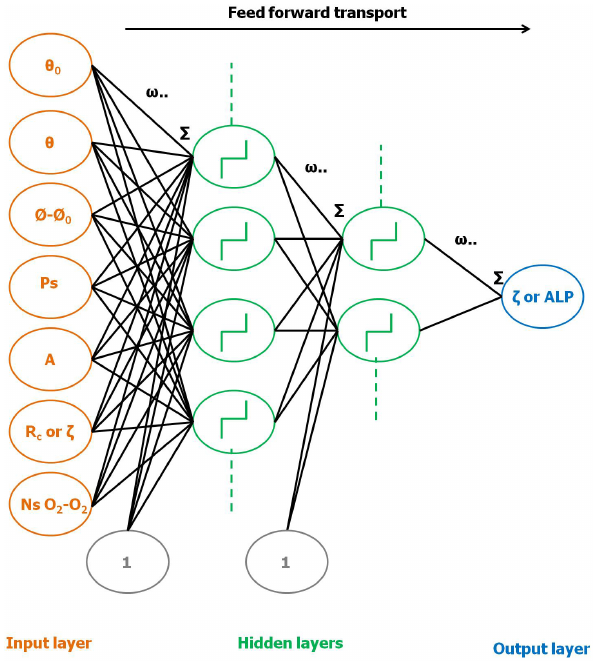
Figure 2. Diagram of multilayer perceptron (MLP) neural net- work (NN) architecture designed for aerosol layer pressure (ALP) and aerosol optical thickness τ retrieval algorithms from the OMI O 2 − O 2 spectral band at 477nm. The input parameters are based on the list given in Table 1. The different considered approaches for the MLP design and their applications are more detailed in Sect. 3. Each circle represents a specific processor (named neuron) includ- ing either an input–output variable (in the input–output layer) or the activation function (i.e. sigmoid function in the hidden layer). The synaptic weights ω ensure the connections of neurons between two consecutive layers. A weighted sum P is performed before the transport through the activation function. Note the presence of the bias neurons, prior to the activation functions in the hidden lay- ers. For simplicity, bias neurons are commonly visualized as val- ues added to each neuron in the input and hidden layers of a net- work, but in practice are treated in exactly the same manner as other weights: all biases are simply weights associated with vectors that lead from a single node whose location is outside of the main net- work and whose activation is always 1. While the synaptic weights essentially change the steepness of the activation functions, the bias neurons allow to modify the origin of these functions from 0 to pos- itive or negative